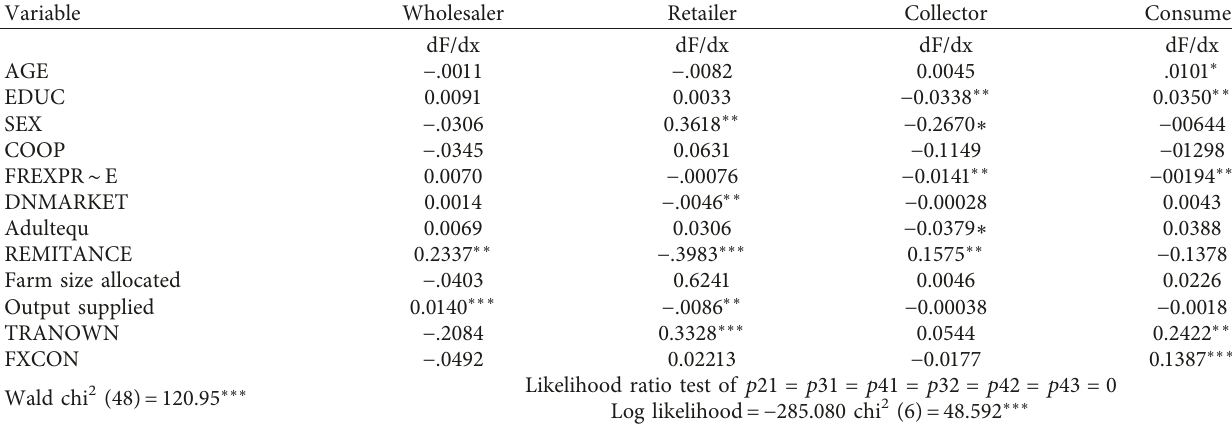
Table 5: Marginal effect after multivariate probit model